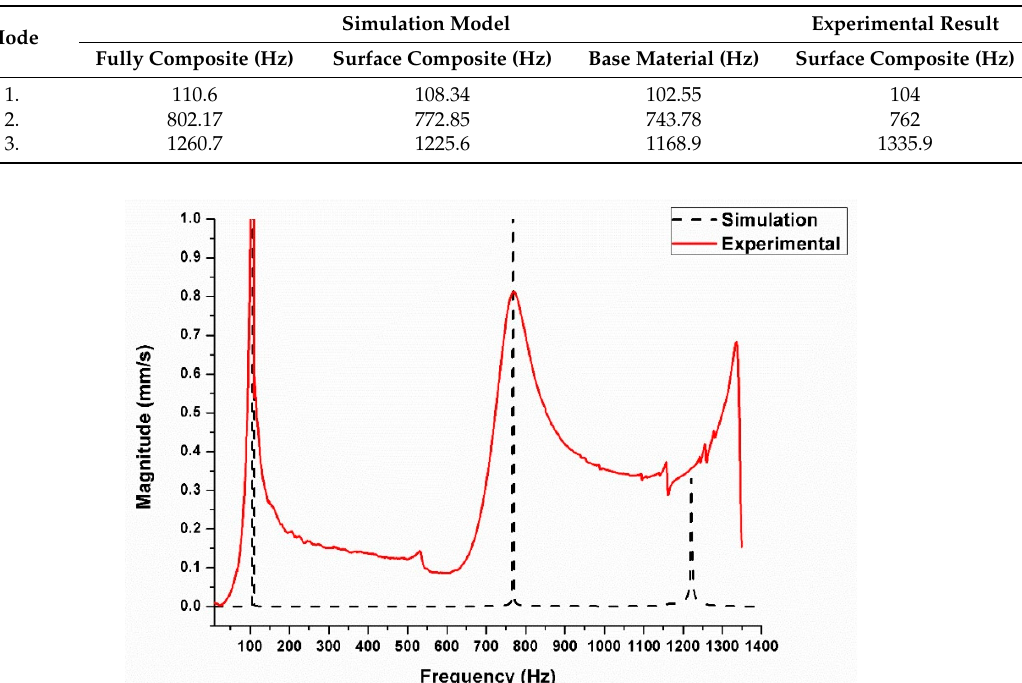
Figure 9. Frequency response function (FRF) comparison between the experimental free vibration test and the simulation modal for the surface composite beam with an average Young’s modulus of 65 GPa.